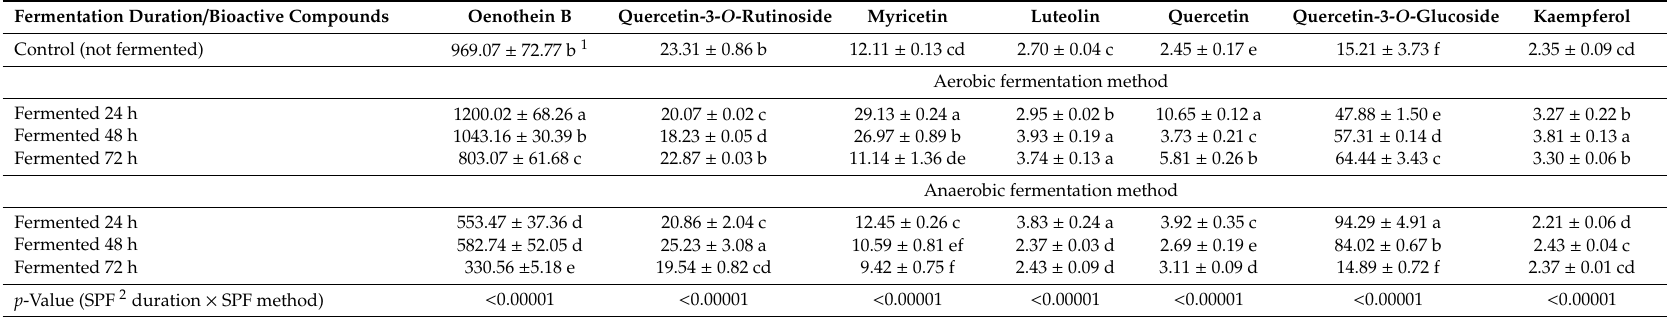
Table 3. The influence of SPF on the content of flavonoids and tannin (mg 100 g − 1 DW) in organic willowherb leaves. Mean value ± standard error, n =